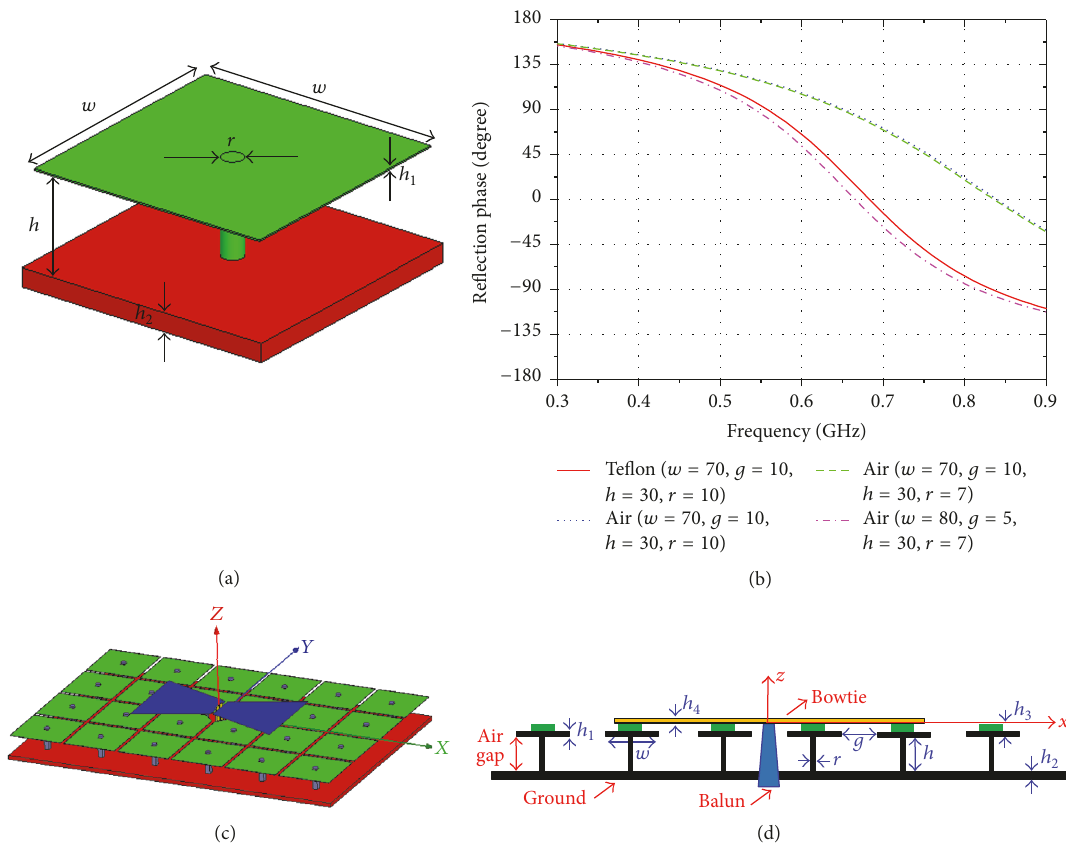
Figure 8: The low-profile bow tie antenna on substrate-less HIS: (a) substrate-less HIS unit cell, (b) reflection phase response, (c) 3D view, and (d) cross-sectional view.